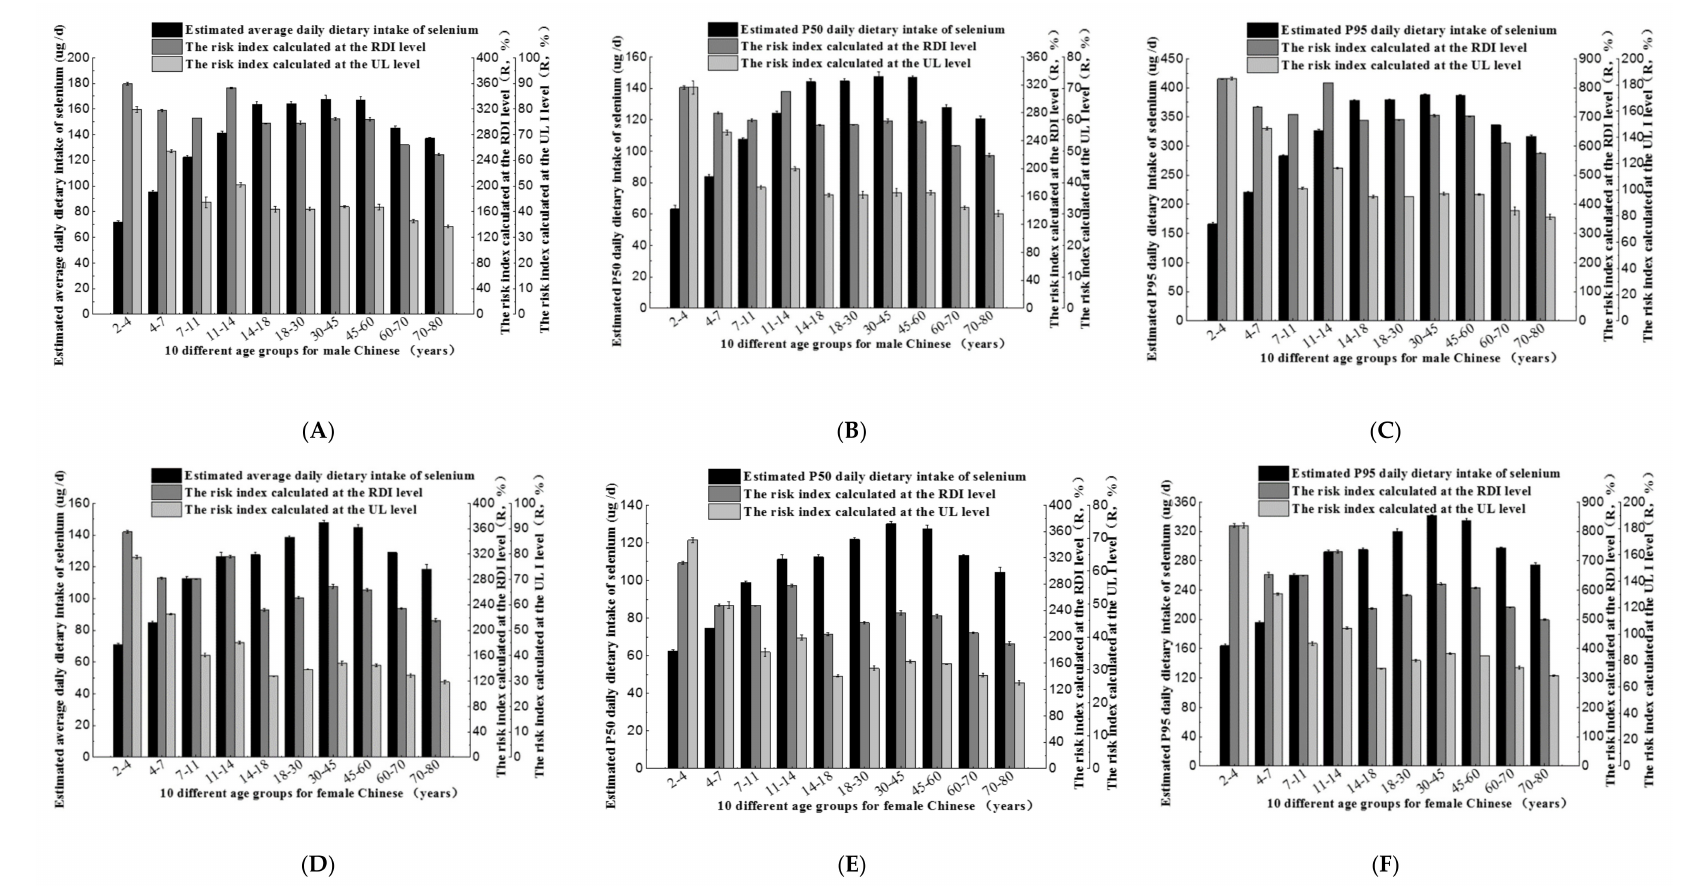
Figure 4. Dietary selenium intake and risk assessment of male ( A) –( C ) and female ( D) –( F ) population in di ff erent age groups when they only eat selenium-rich rice. When the risk index was calculated, the actual daily dietary selenium intake data of male and female population in di ff erent age groups was from the study by Nie J Y in 2015 and “dietary guidelines for Chinese residents in 2016”. The RDI and UL data of male and female population in di ff erent age groups was selected by reference to selenium intake recommendations from the FAO (Food and Agriculture Organization of the United Nations) / WHO (World Health Organization) and the NNFA (US National Nutritional Foods